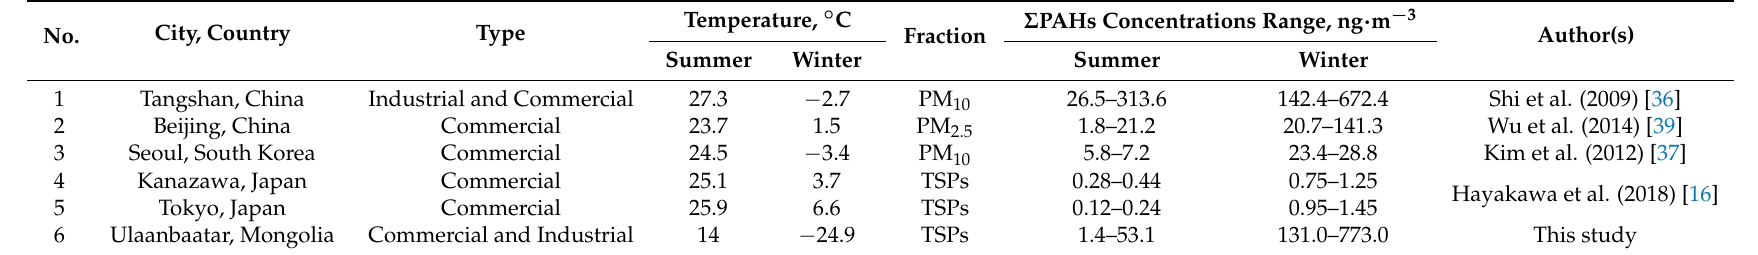
Table 5. The temperature and PAH concentrations in other Asian cities. TSPs: total suspended